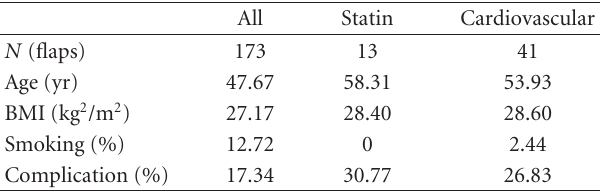
Table 1: patient characteristics per study